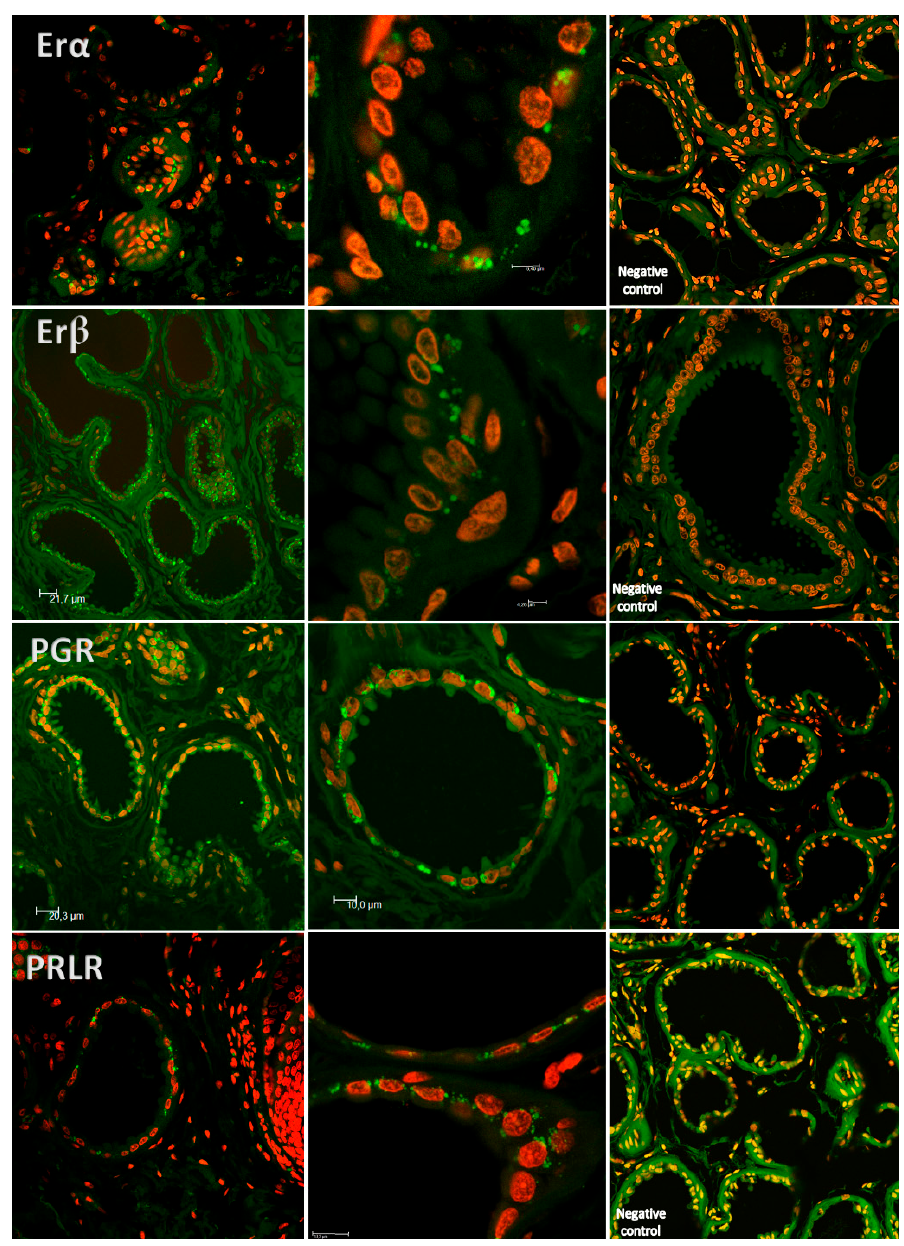
Figure 5. Examples of laser-scanning confocal fluorescence (LSC—lens 63.03 oil) images of IGS. One can observe immunoreactivity towards ESR1, ESR2, PGR and PRLR in cells of the apocrine glands labeled with PE and stained for the different receptors (fluorescence in green). Use of To-Pro-3 iodide for nuclear counterstaining (fluorescence in red).